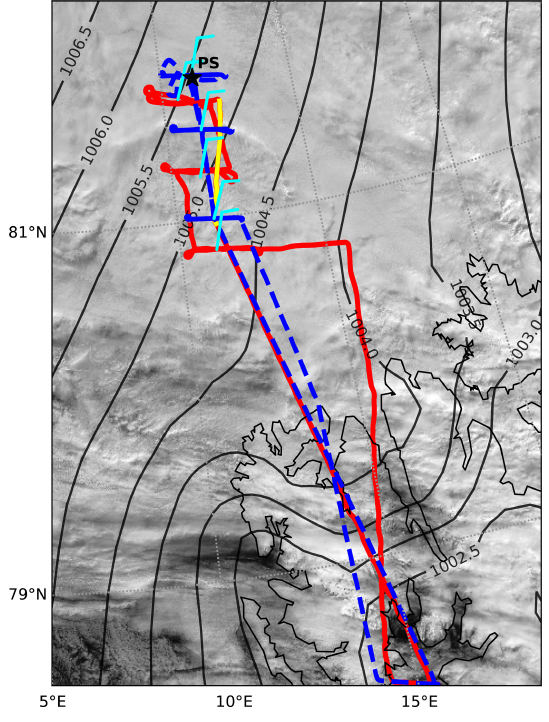
Figure 8. Tracks of Polar 5 (blue) and Polar 6 (red) on 14 June 2017 overlaid over MODIS satellite images. The wind barbs are showing the wind speed and direction averaged over the profile seg- ments within the ABL. Only the northernmost cross-wind leg of Polar 6 and the two northernmost cross-wind legs of Polar 5 are analyzed. The yellow line marks the descend of Polar 6 used for the analysis.